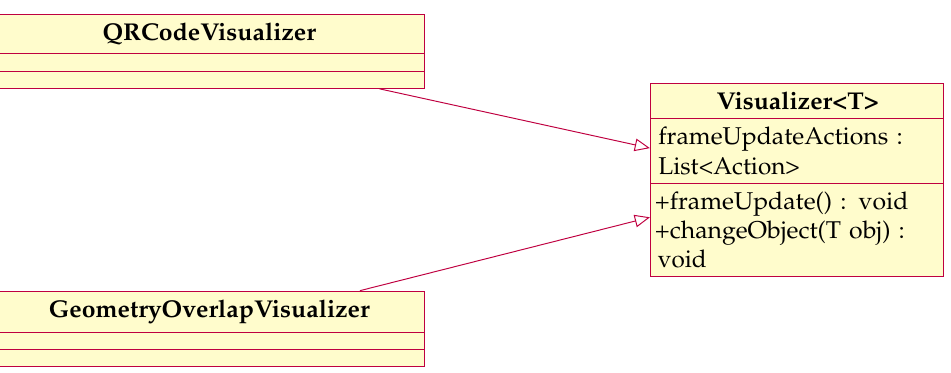
Figure 17. Class diagram of the ByteToAssetTransformer with all the functions and fields and its connection to its parent class.